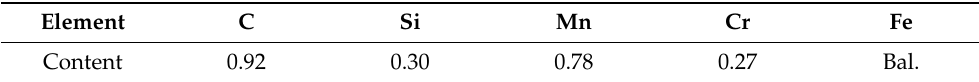
Table 1. Chemical composition of glossy steel wire (wt%). Element